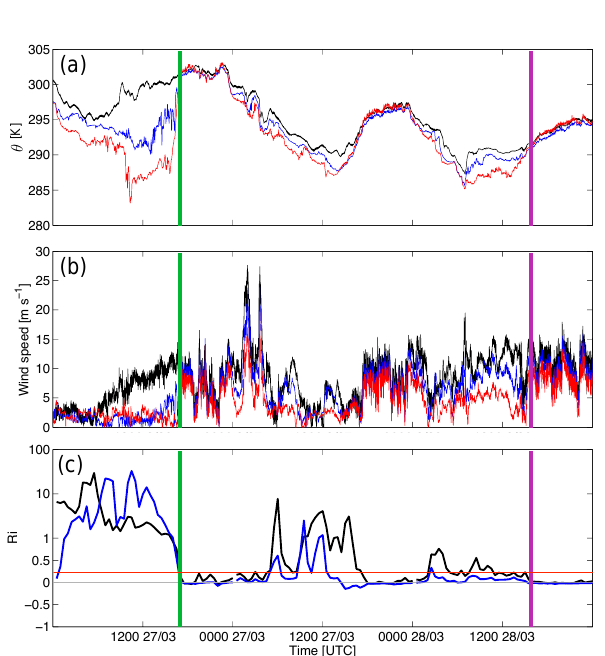
Figure 2. Evolution of θ (a) , wind speed (b) , and Ri (c) over the 2-day observational period from 26 to 28 March, 2014. The colours indicate the height of the measurement on the BAO tower, for which red is 10m, blue is 100m, and black is 300m. Thick green lines de- note when DLs were set up and began operating near the tower, while the magenta lines indicate the end of this observational pe- riod. Red horizontal line in (c) shows Ri = 0.25 for reference, above which conditions typically are strongly stable and turbulence be- comes intermittent.